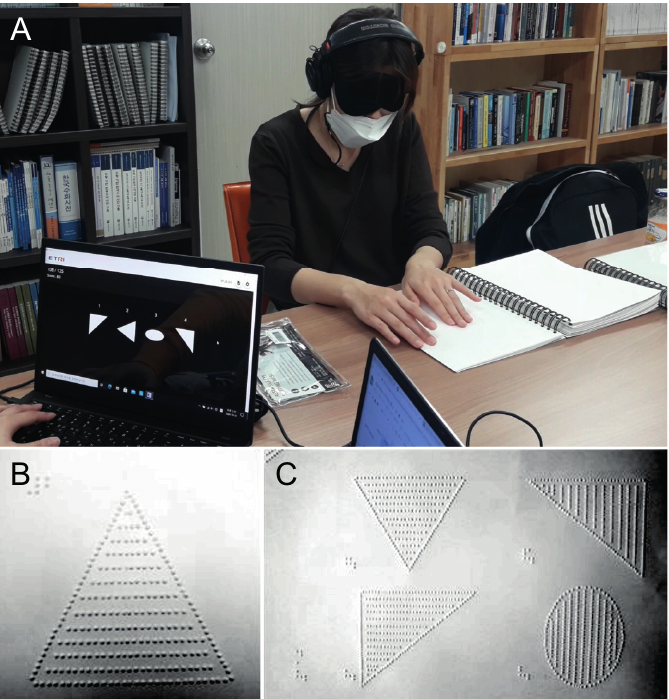
Figure 3. ( A ) The participant wearing a blindfold and listening to the soundscape produced from the shape image displayed on the screen, determining the mappings between shape and sound using the braille print by hand. ( B ) Example of braille print for session training. ( C ) Example of braille print for